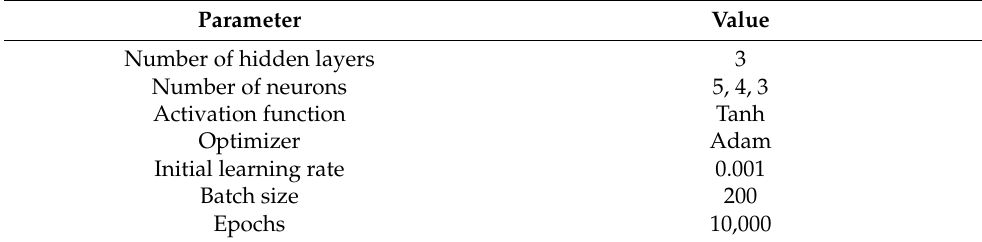
Table 2. Hyperparameters of the deep neural network regression model. Parameter Value Number of hidden layers 3 Number of neurons 5, 4, 3 Activation function Tanh Optimizer Adam Initial learning rate 0.001 Batch size 200 Epochs